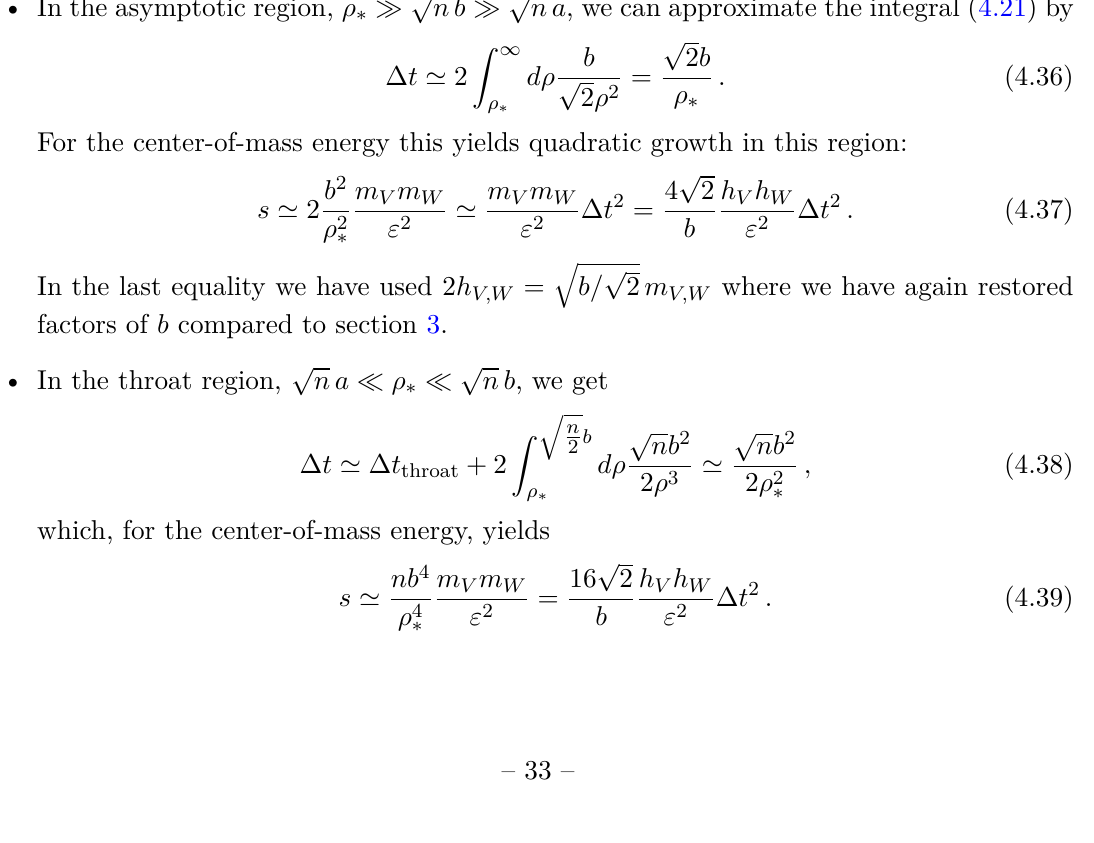
√ 2 , m = m = 10 and V W